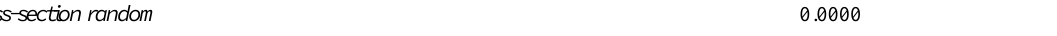
Table 2: Chow Test Result